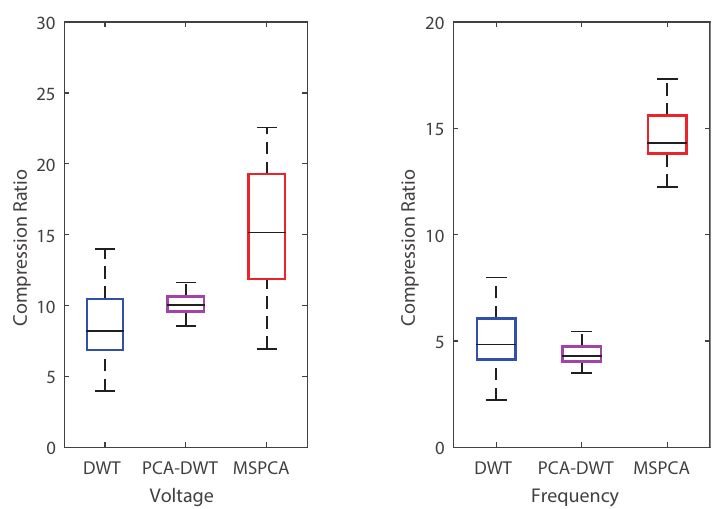
Figure 11. Compression-ratio results for 24 h of PMU data.